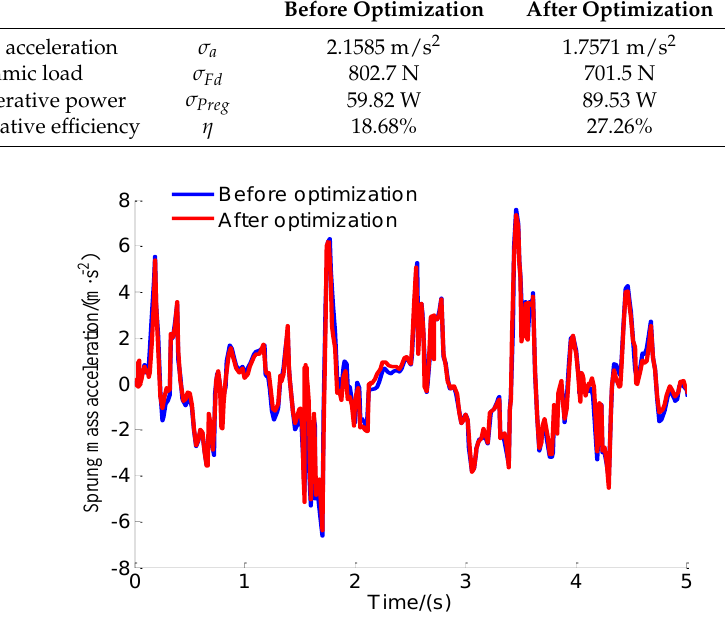
Figure 9. Spring mass acceleration response curve. Algorithms 2018 , 11 , x FOR PEER REVIEW